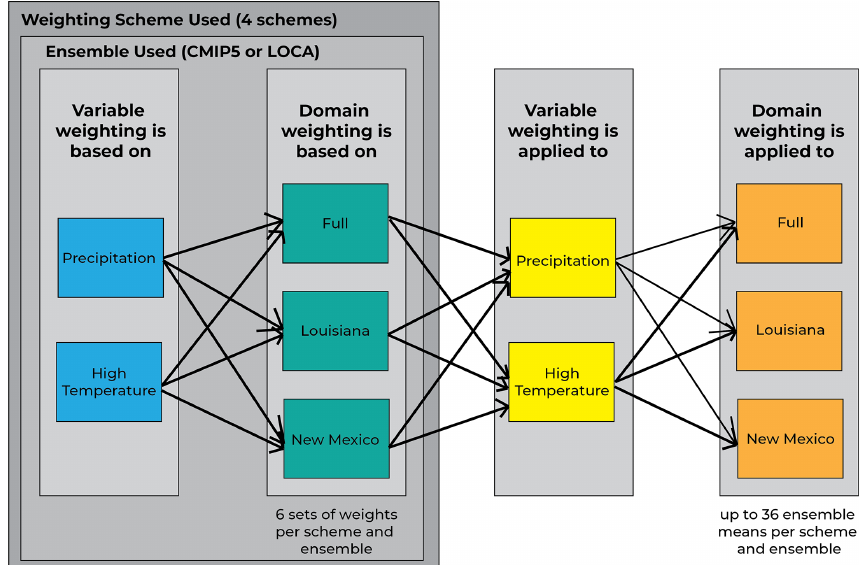
Figure 2. Flowchart showing the process of analysis with weighting schemes. Each version of the model average is constructed based on several choices: (a) the choice of the ensemble (CMIP vs. LOCA), (b) the choice of model weighting strategy (unweighted, Skill, SI-h, SI-c, or BMA), (c) the choice of climate variable of interest (precipitation or temperature), and (d) the choice of the domain used for the ensemble averaging (entire south-central region, Louisiana, or New Mexico). These various choices add up to 48, plus the unweighted version, so there are 49 overall choices of model weighting strategies. Then, once the model average is constructed and trained, there is a choice to be made regarding which variable and which domain to apply this model average to. Therefore, this results in 48 × 2 × 3 = 288 possible future outcomes in our experimental matrix plus two unweighted outcomes for a total of 290